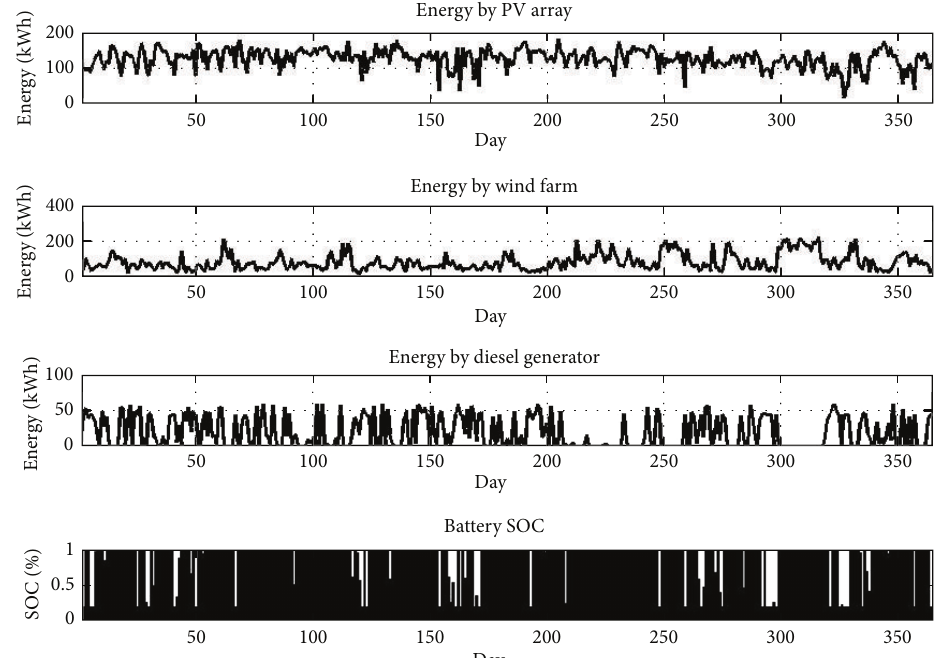
Figure 7: Energy generation share of the proposed system.